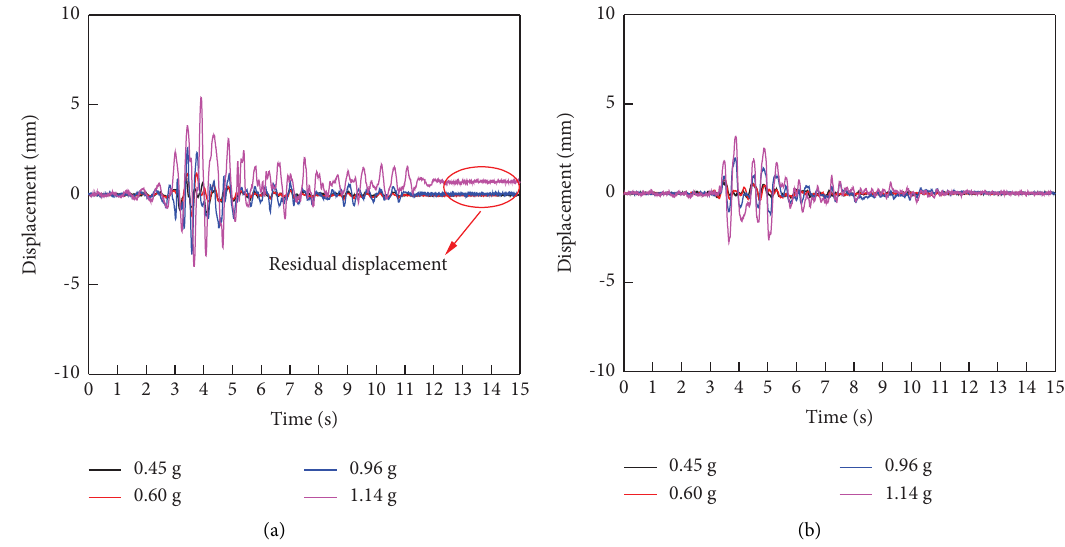
Figure 12: Relative displacement of Pier 1 and the continuous girder under diferent earthquake intensities for (a) x direction and (b) y